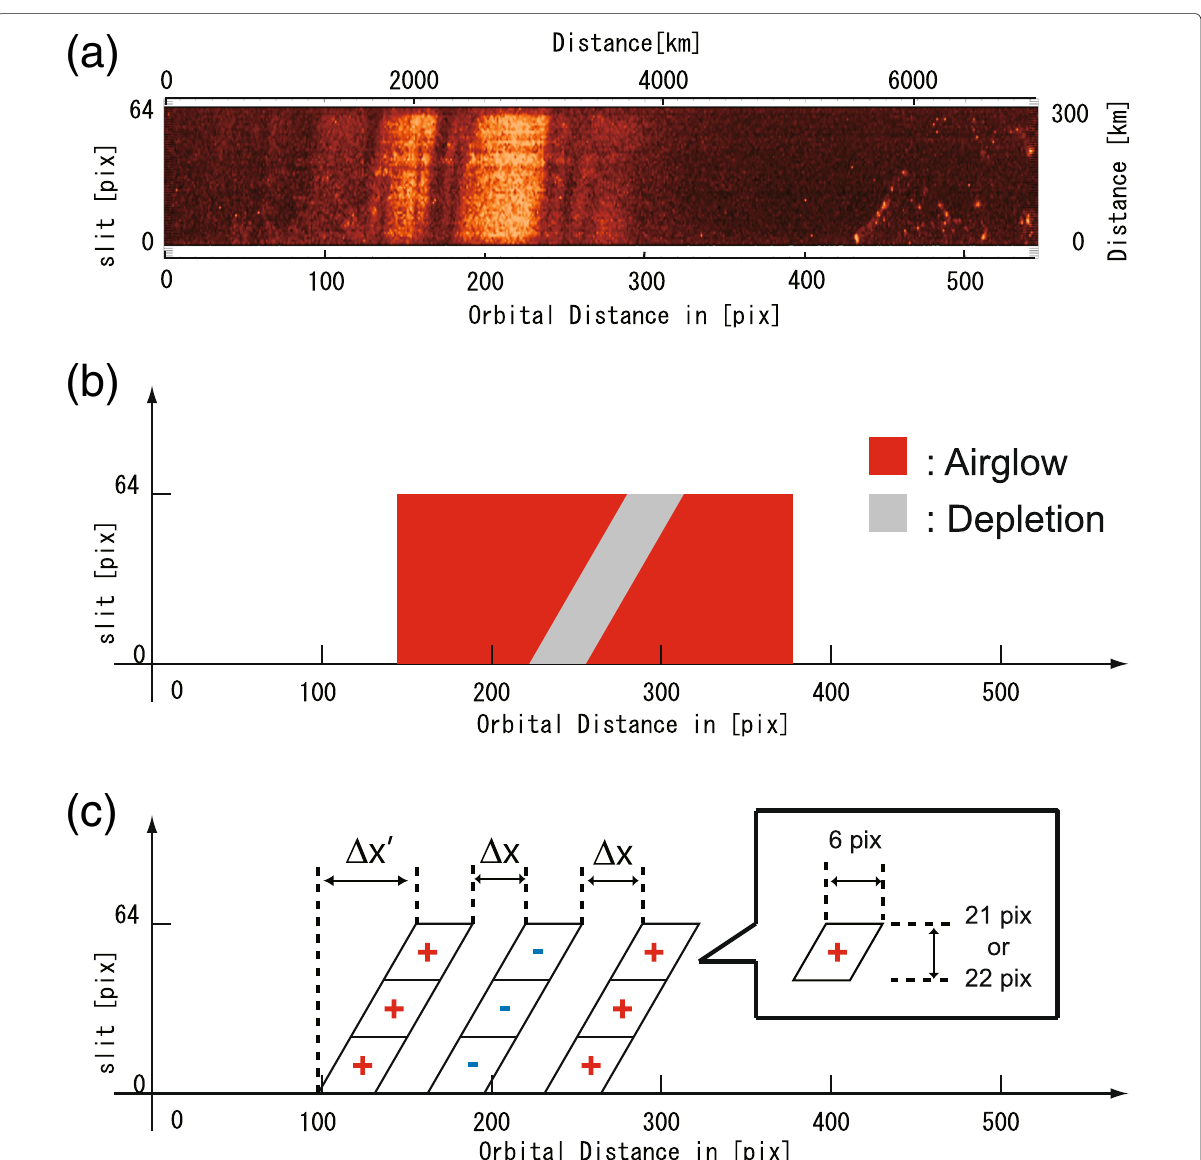
Fig. 2 The schematic figure of the selection of the EPB events. The top panel a shows the airglow image obtained on 25 September 2012. The middle panel b shows the model image of the tilted EPB as shown by an arrow in the top panel. To detect this EPB, the spatial variations of the airglow shown in the bottom panel c were sought